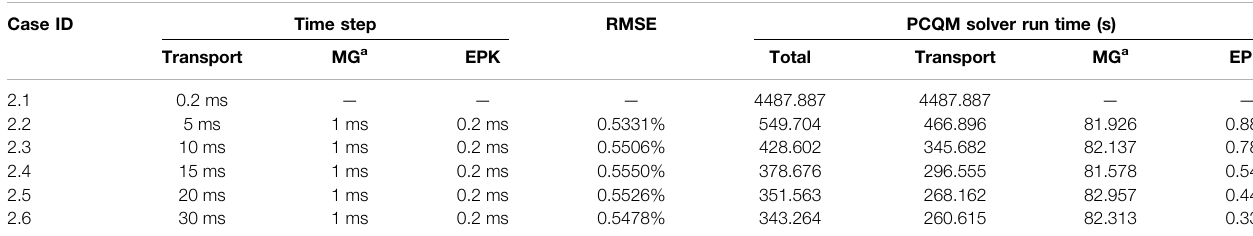
TABLE 3 | Results of accuracy and ef fi ciency for the TML cases in Problem 2.